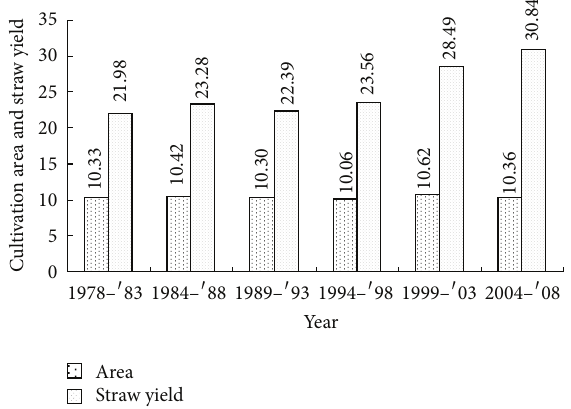
Figure 1: Yearwise distribution of rice growing area (ha × 10 6 ) and rice straw yield (mt × 10 6 ) in Bangladesh .